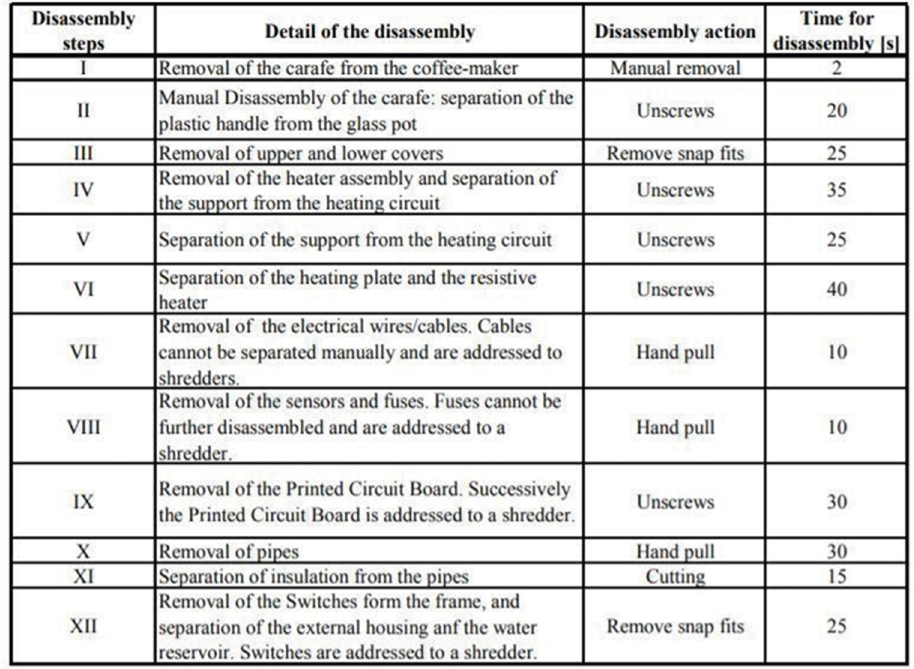
Figure 4. Coffee maker disassembly lines (Ardente, Wolf, Mathieux & Pennington,